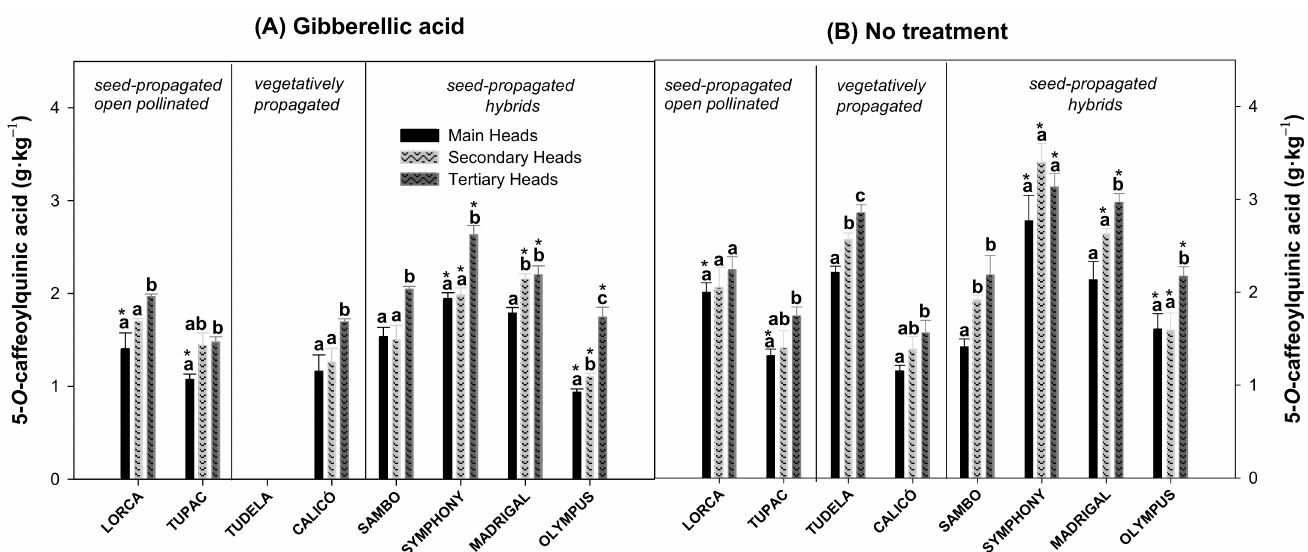
Figure 2. The 5- O -caffeoylquinnic acid content (g · kg − 1 ) of globe artichoke cultivars influenced by flower head order (main, secondary, and tertiary heads) and treatment (gibberellic acid ( A ) or no treatment ( B )). Data are the mean ± SE. Different letters show significant differences ( p < 0.05 according to HSD Duncan’s test) among flower head orders for each artichoke cultivar and treatment. Significant differences between both treatments ( p < 0.05 according to Student’s t -test) were expressed as * placed in each flower head order for each artichoke cultivar.